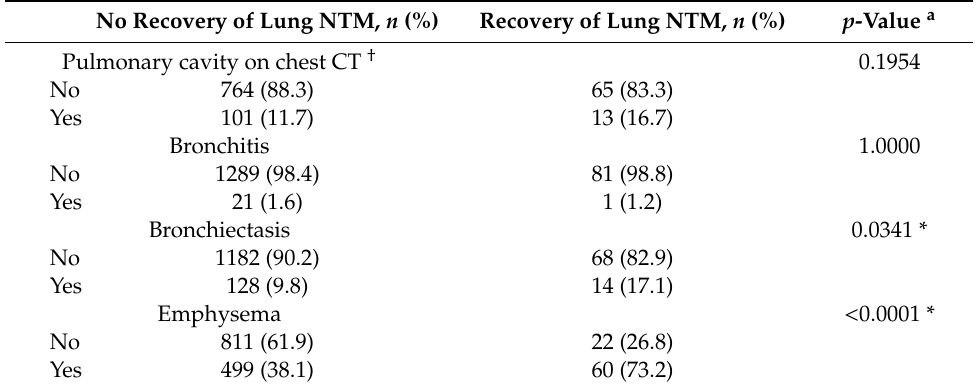
Table 2. Di ff erences between patients with and without NTM lung infection in terms of selected radiological